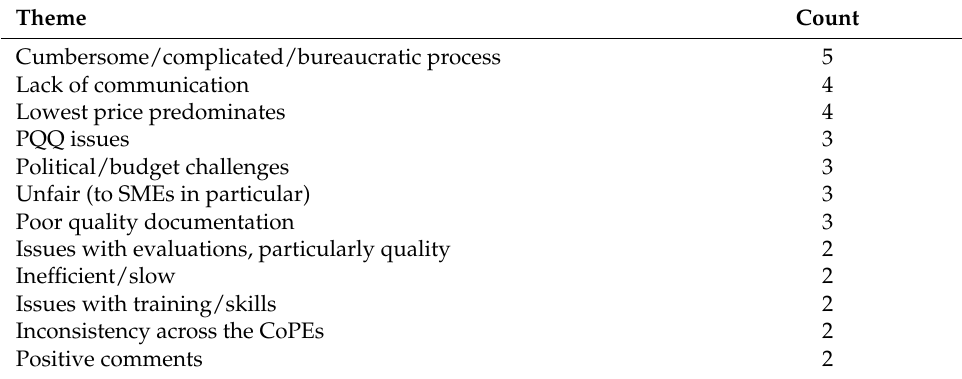
Table 9. Thematic analysis on views as to whether procurement in NI is well managed or